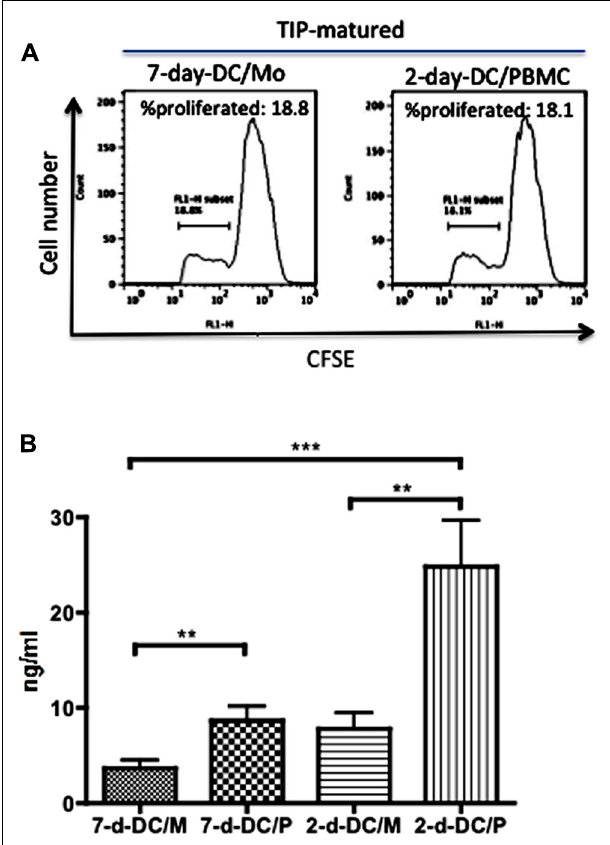
FIGURE 3 | High levels of production of IFN- γ by allogeneicT cells stimulated with 2-day-DCs generated from PBMCs. Matured MDDCs (7-day-DC/Mo) and 2-day-DCs generated from PBMCs (2-day-DC/PBMC) were co-cultured with CFSE-labeled allogeneic CD4 + T cells at DC toT cell ratio of 1:50 for 4 days.The cell number of DCs in 2-day-DC/PBMC was manually counted using a Burker-Turk hemo-cytometer in which only large cells were counted. (A) Percentages of proliferated cells were examined by flow cytometry. (B) The levels of IFN- γ produced in the supernatants were quantitated by ELISA. In addition to the DCs shown in (A) , MDDCs generated from PBMCs for 7 days (7-d-DC/P) and 2-day-DCs generated from purified monocytes (2-d-DC/M) were also tested. Data shown are representative of three independent experiments using blood from two different